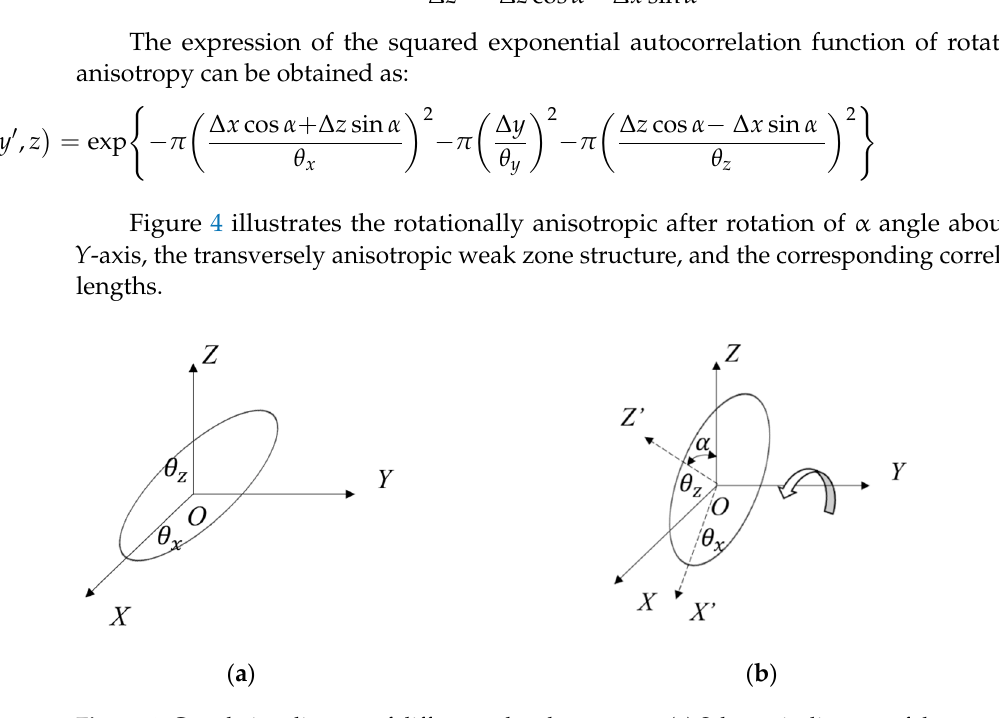
Figure 4. Correlation distance of different related structures. ( a ) Schematic diagram of the correlation length of y = 0; ( b ) correlation length of rotational anisotropy after rotation of the α angle about the Y -axis. For rotated anisotropy around the Z -axis, the correlation distance after rotation can